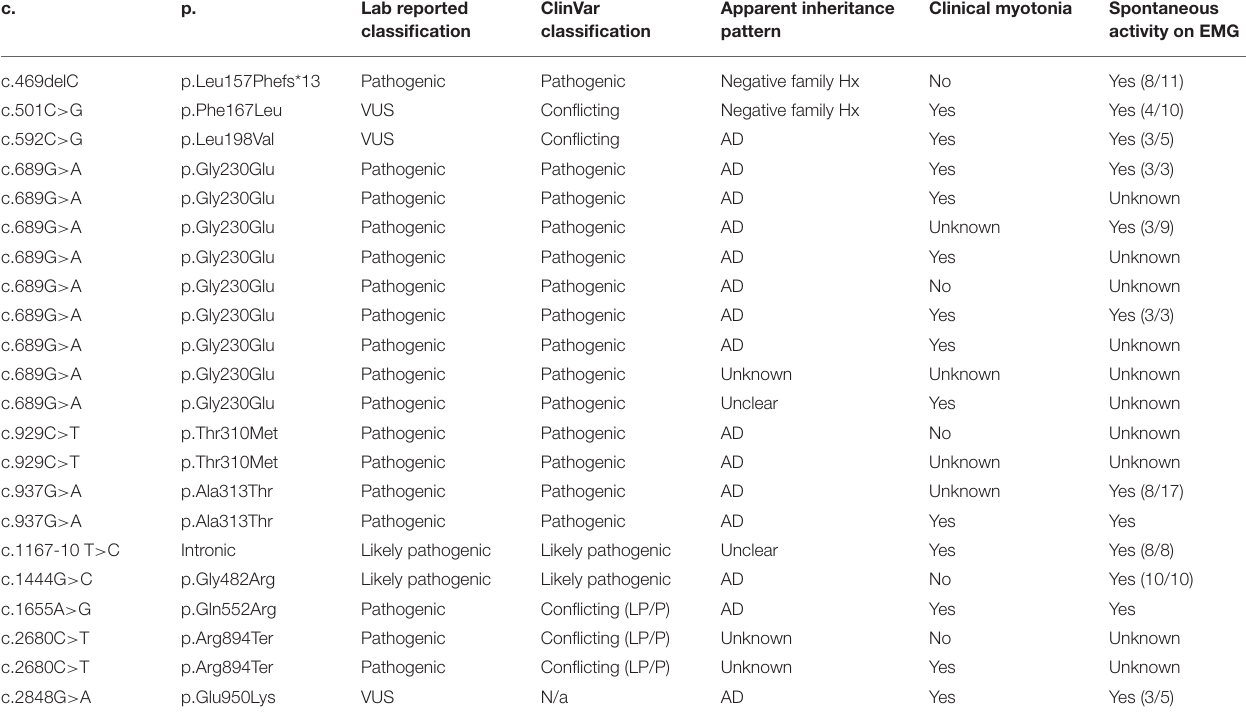
TABLE 2 | List of patients with one variant identified in CLCN1